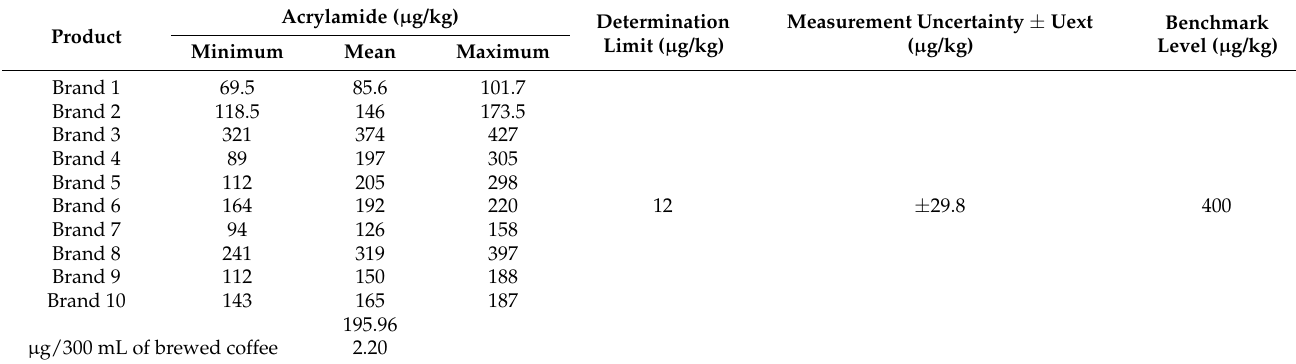
Table 2. The acrylamide level in Arabica ground roasted coffee ( µ